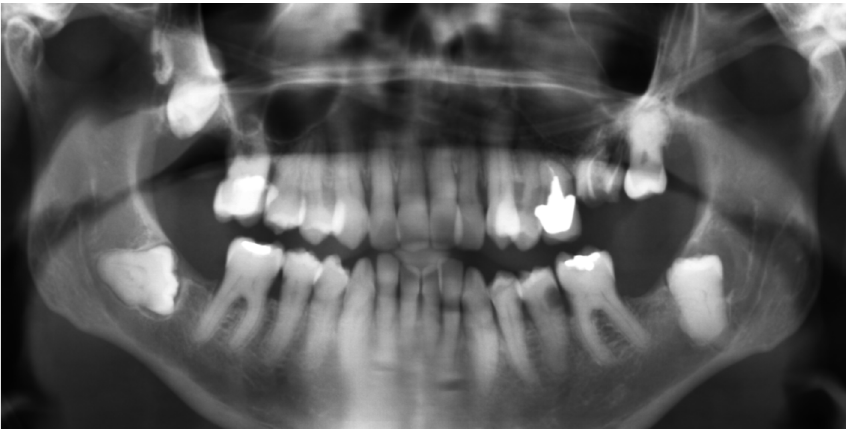
Fig. 2. Panoramic X-ray showing infectious foci of 26, 35, and